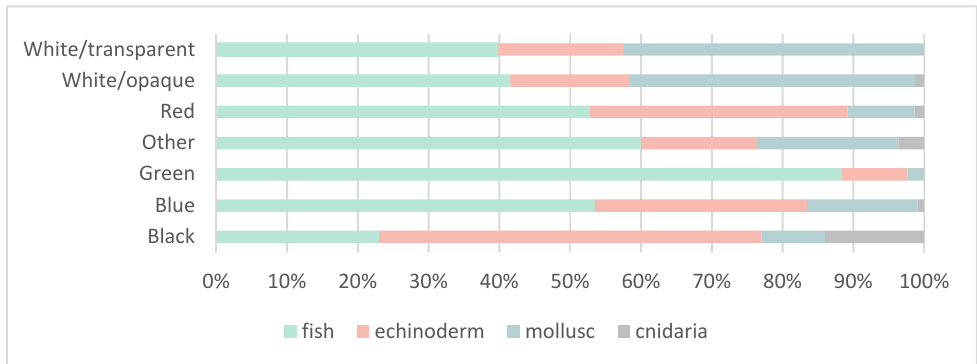
Figure 2. Bar graph regarding the colour of identified items from the gastrointestinal contents of fish (green), echinoderm (red), mollusc (blue) and cnidaria (grey). Each bar indicates the percentage of occurrence of each colour group according to analysed species.